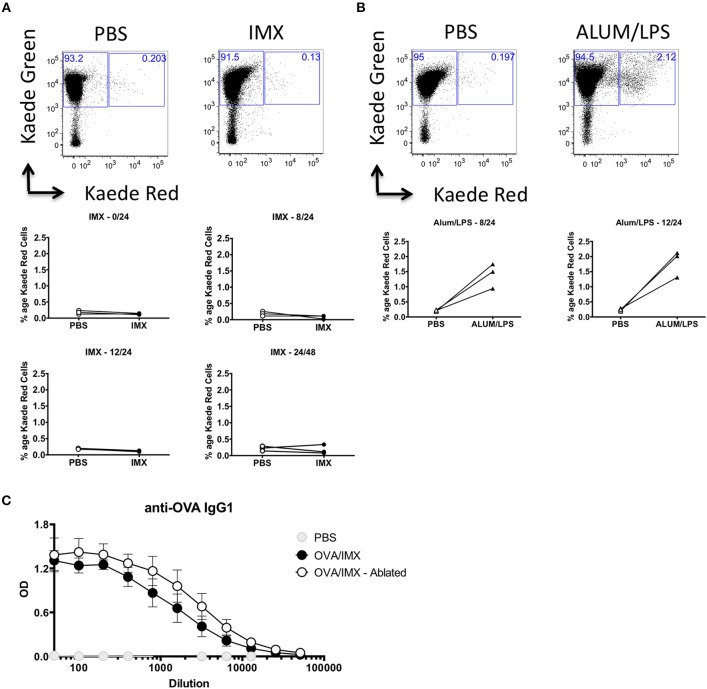
The injection site is not required for ISCOMATRIX adjuvant activity. (A) Representative flow cytometry plots showing Kaede red vs. Kaede green in the popliteal lymph node (top panels) draining the PBS injected (left) and the ISCOMATRIX (right) injected footpad, below plots showing the percentage of the leukocytes in the draining lymph nodes at 24 h following photoswitching immediately prior (middle left), 8 h post (middle right) 12 h post (bottom left) immunization or at 48 h from mice photoswitched at 24 h (bottom right). (B) Representative flow cytometry plots showing Kaede red vs. Kaede green in the popliteal lymph node (top panels) draining the PBS injected (left) and the ALUM/LPS (right) injected footpad, below plots showing the percentage of the leukocytes in the draining lymph nodes at 24 h following photoswitching 8 h post (bottom left) and 12 h post (bottom right) immunization. (C) Serum anti-OVA IgG1 from mice at 14 days post immunization with PBS, OVA/ISCOMATRIX with the injection site intact or OVA/ISCOMATRIX with the injection site removed shortly following immunization. Groups contained 3 animals and data is representative of two independent experiments. IMX = ISCOMATRIX™ adjuvant.